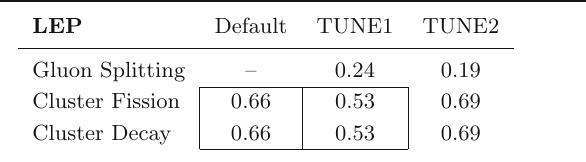
Table 1 Results of the parameter values for strangeness production at the different stages of the event generation (LEP). In both default Herwig and TUNE1, cluster fission and decay have the same parameter. In TUNE2, they are allowed to be different, but the tuning